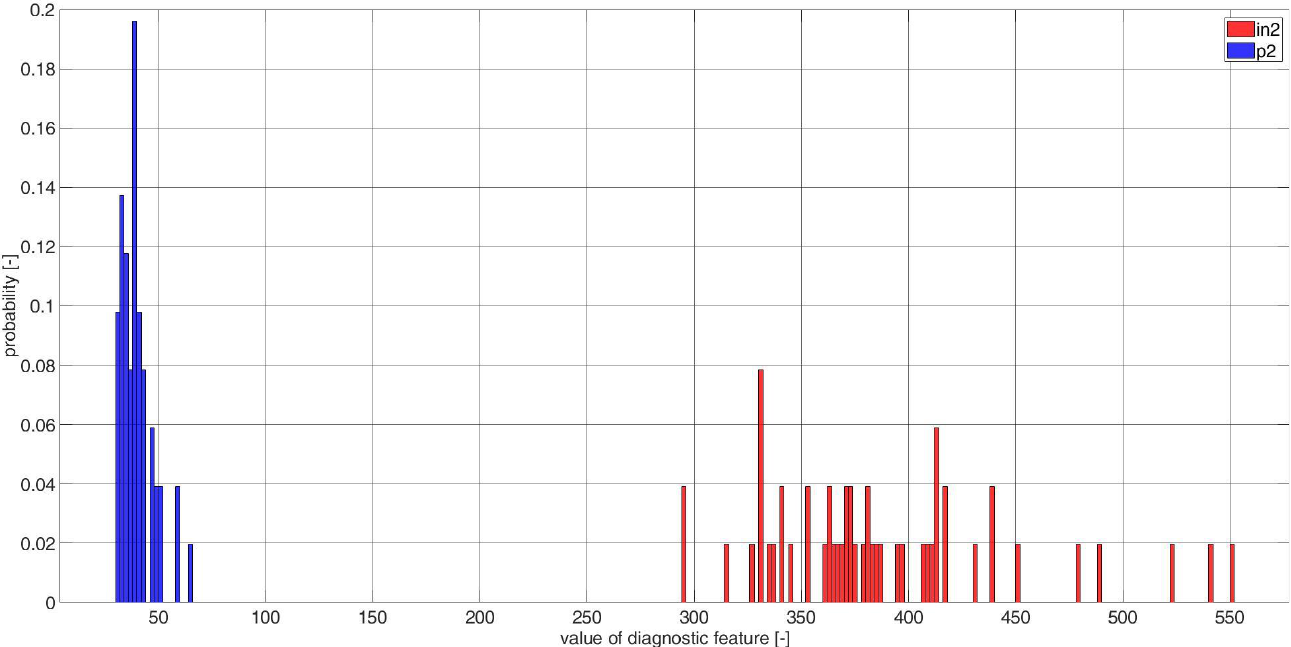
Figure A15. Histograms of diagnostic features based on the CCSM3 (correlation number is 13—Table A1), bearings in1 and p1.